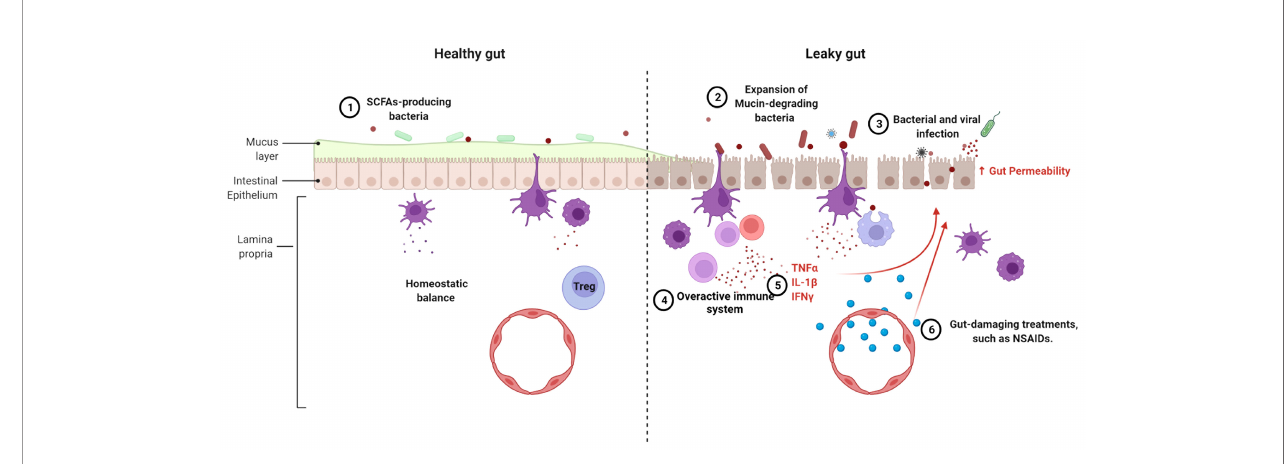
FIGURE 2 | Mechanisms leading to the loss of gut barrier integrity in lupus. The following mechanisms can compromise a healthy gut (left) leading to a leaky gut (right), singly or in combination, 1. The reduction or even loss of SCFA-producing bacteria is linked to alterations of the mucus layer lining the gut. 2. Expansion of mucin-degrading bacteria, such as R. gnavus , promotes gut leakage. 3. Frequent intestinal infections induce in fl ammation and tissue damage. 4. The overactive immune system leads to chronic in fl ammation and recruitment of in fl ammatory cells. 5. Proin fl ammatory cytokines affect gut integrity. 6. Some lupus treatments cause damage on gut barrier